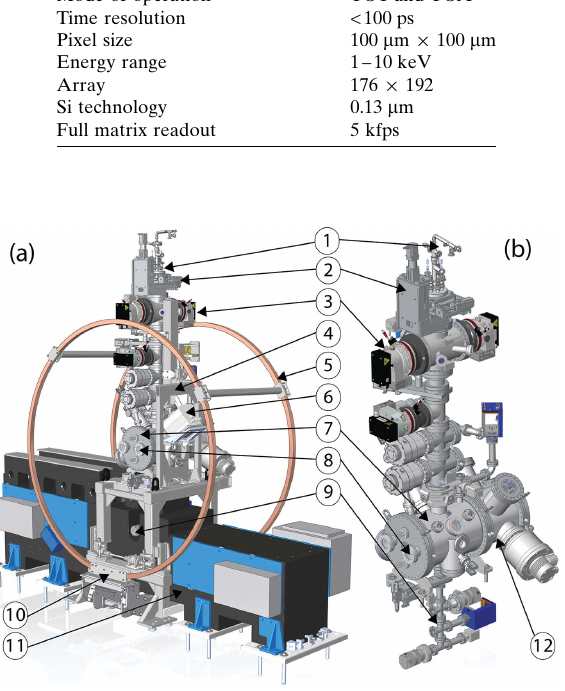
Figure 7 Overview of the DREAM instrument shown as endstation mounted on the support granite ( a ), and the chamber assembly without support infrastructure ( b ). Indicated are the CW supersonic jet (1), the three-axis jet manipulator (2), the first skimmer stage pumping (3), the four skimmer section (4), the Helmholtz coil pair (5), the long-range microscope (6), the main chamber (7), the close optical laser in-coupling next to the out-coupling (8), the two-stage catcher section with residual gas analyser (RGA) (9), the three-axis coil mover (10), the support granite (11), and the extension chamber (12).